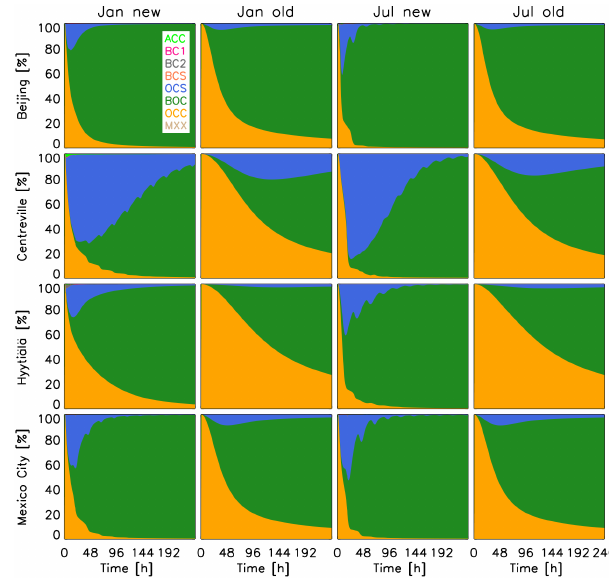
Figure 5. Temporal evolution of organic aerosol mass concentra- tion fraction in each organics-containing population from the new scheme (first column for January, third column for July), and the old scheme (second column for January, fourth column for